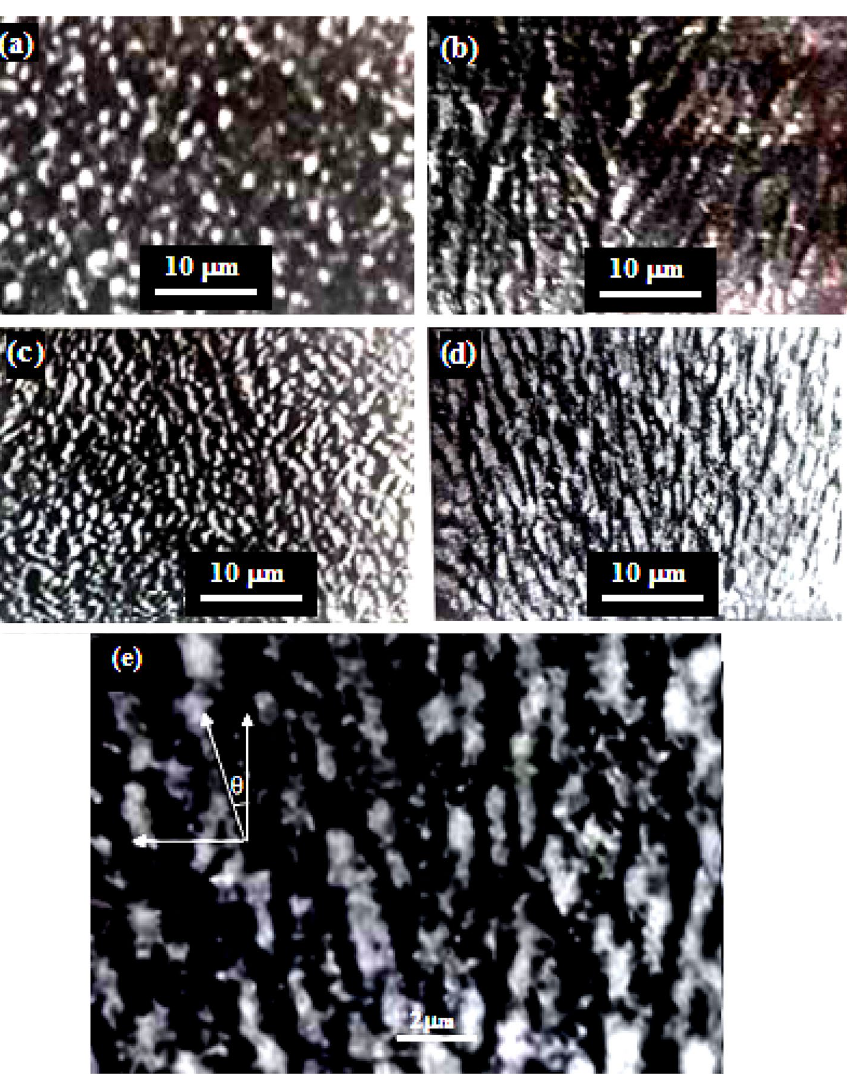
Figure 3. SEM images of antimony films deposited at ( a ) θ = 0°, ( b ) 10°, ( c ) 30°, ( d ) 70°, and ( e ) shows the tilted grains of the film deposited at